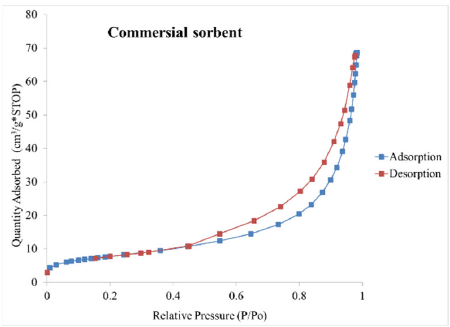
Figure 21. Absorption ‐ desorption isotherms of nitrogen for the commercial sorbent.